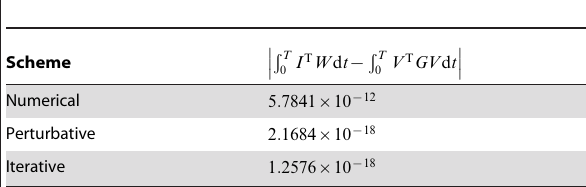
Table 5. Comparison of the three solutions’ preservation of the energy balance